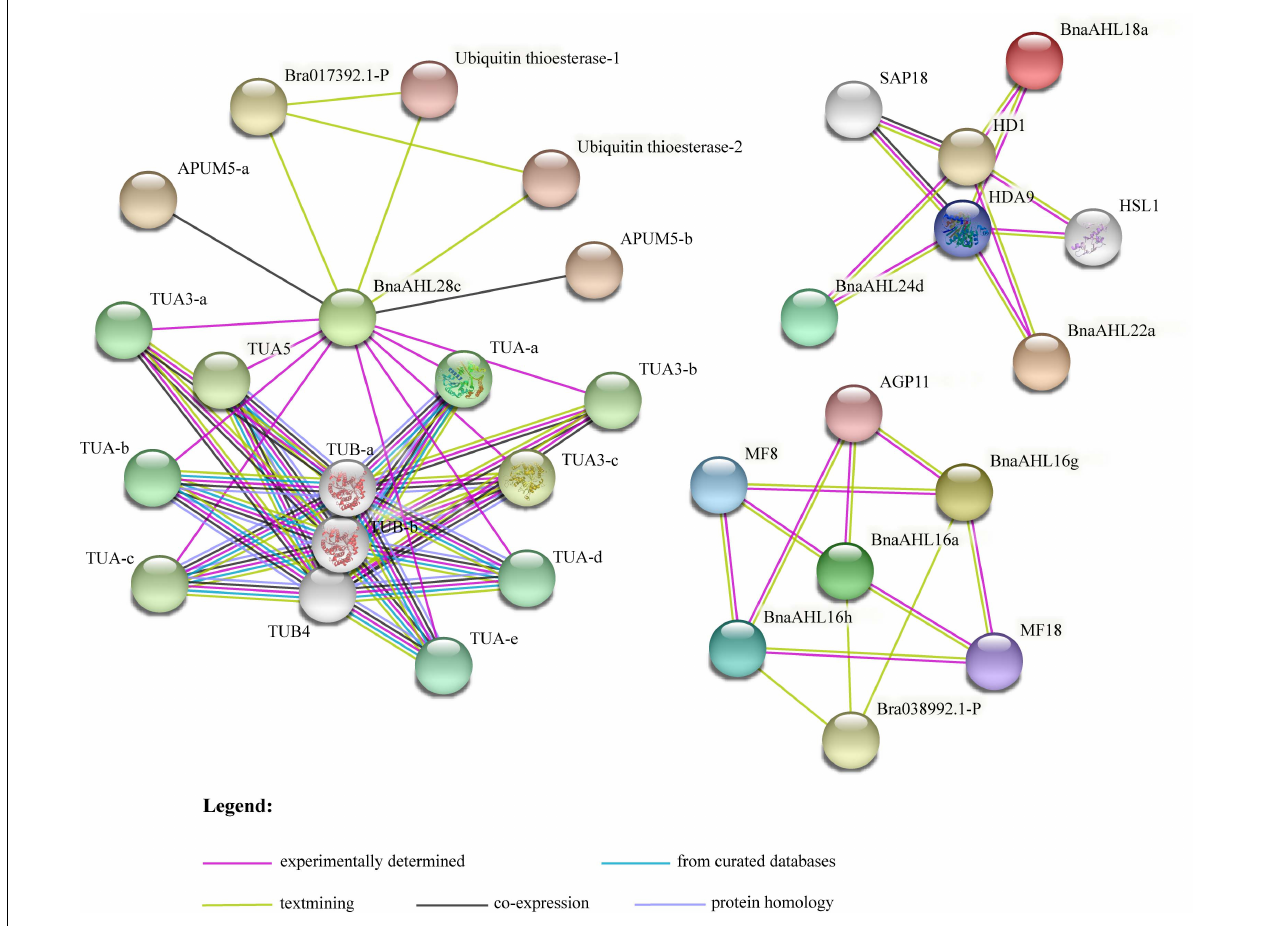
FIGURE 9 | The interaction network of BnaAHL proteins. The line color indicates the type of interaction evidence. The legend is at the bottom of the